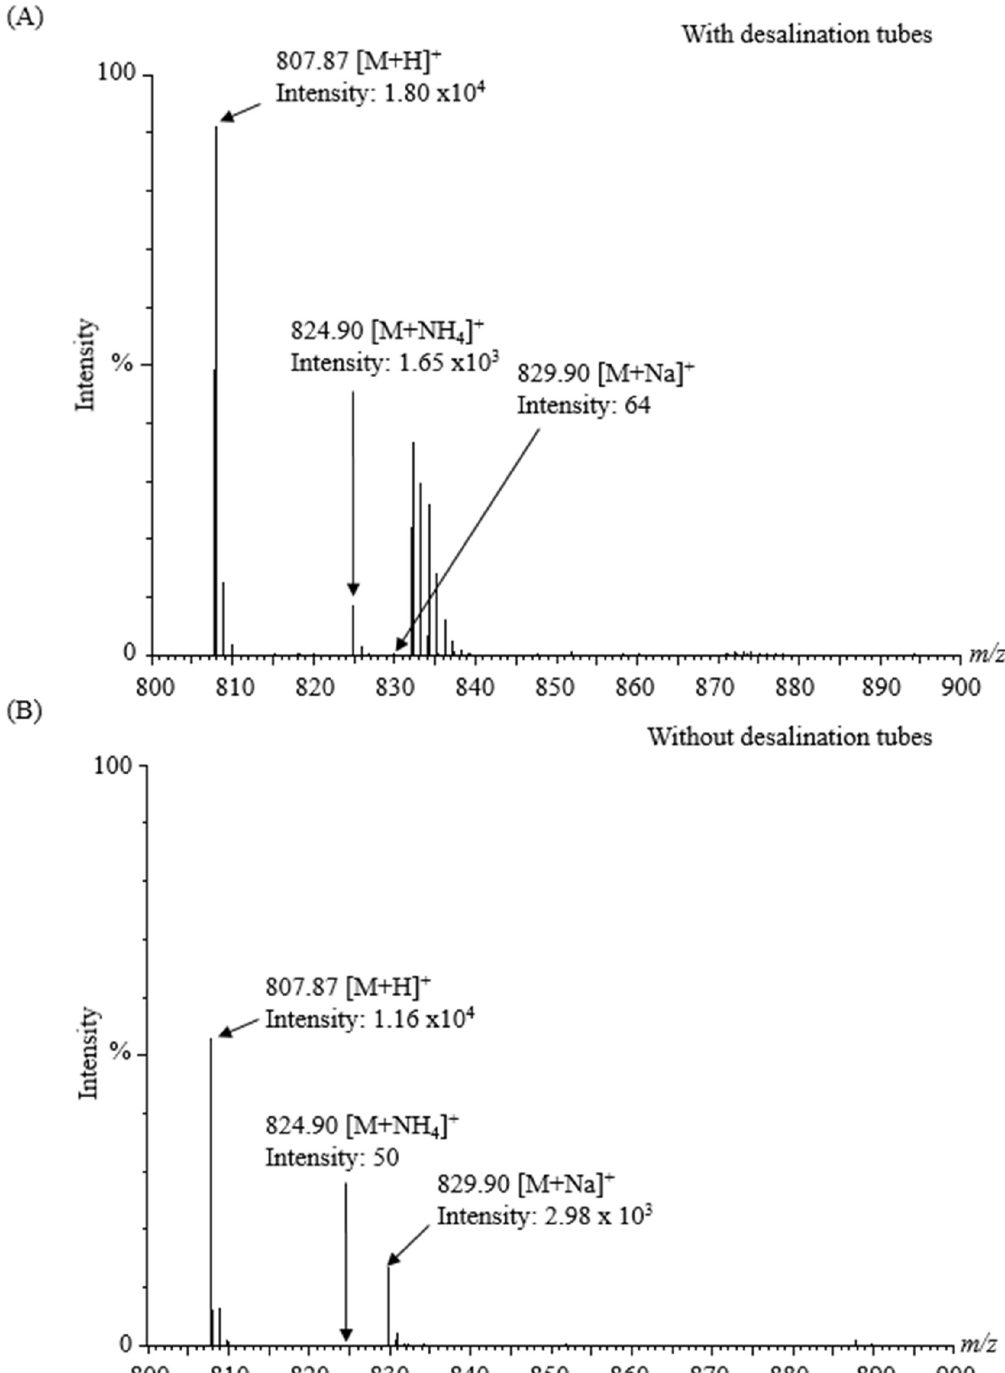
Fig 3. Ioversol was not adsorbed by desalination tubes. (A) Mass spectra were obtained using the desalination tube and (B) mass spectra were obtained without the desalination tube.